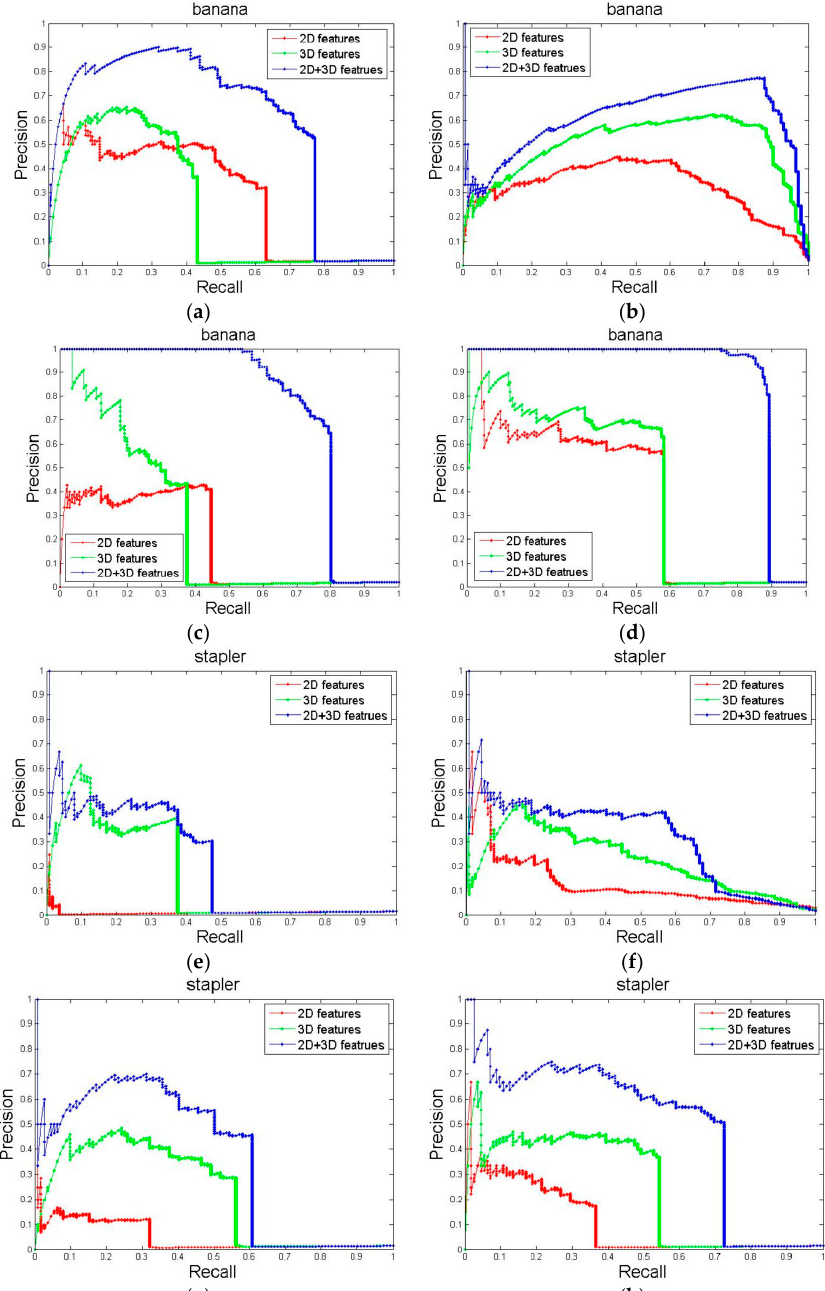
Figure 7. Precision-recall curves comparing performance with 2D shape features only (red), 3D shape features only (green), and both (blue) using 4 different classifiers. ( a ) Result of banana category using NB classifier; ( b ) Result of banana category using NN classifier; ( c ) Result of banana category using LinSVM classifier; ( d ) Result of banana category using kSVM classifier; ( e ) Result of stapler category using NB classifier; ( f ) Result of stapler category using NN classifier; ( g ) Result of stapler category using LinSVM classifier; ( h ) Result of stapler category using kSVM